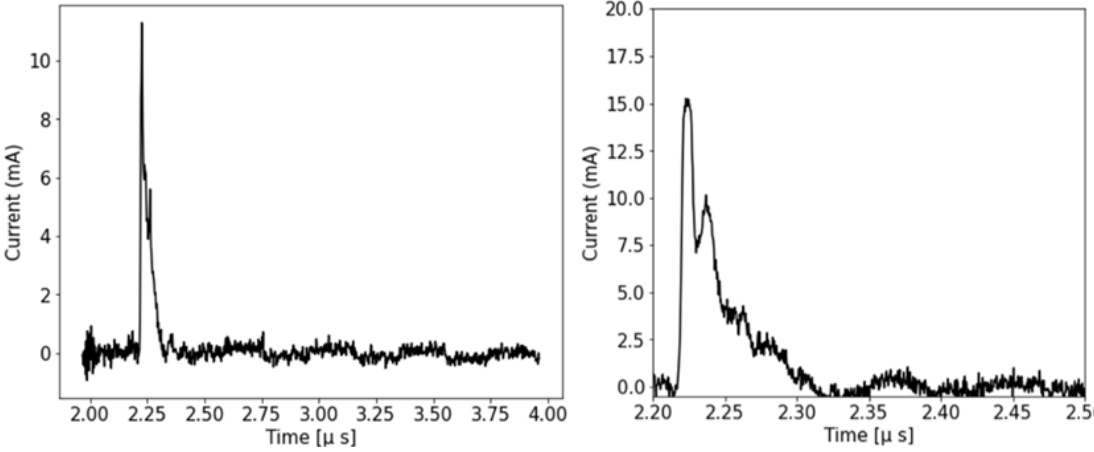
Figure 2. Examples of the proton pulses from NDCX-II used for G-center formation in silicon.